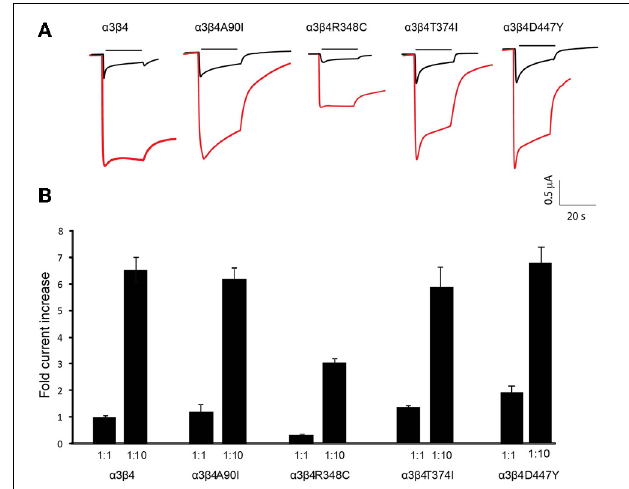
FIGURE 2 | Increased currents by overexpression of β 4 variants. (A) Representative traces of two-electrode-voltage-clamp recordings in oocytes injected with either equal amounts of α 3 and β 4 transcripts (1ng α 3 + 1ng β 4, 1:1 ratio; black traces) or with 10 times more of the β 4 transcript (1ng α 3 + 10ng β 4, 1:10 ratio; red traces). Horizontal line above each trace indicates nicotine (1mM) application. (B) Bar graph indicates the fold increase of the current amplitude elicited by 1mM nicotine with respect to a3b4 wt oocytes injected at 1:1 ( n = 10 oocytes per condition) for oocytes injected with 1:1 or 1:10 rations of the indicated β 4 variants A90I, T374I, D447Y, and R348C. All values are expressed as mean ±